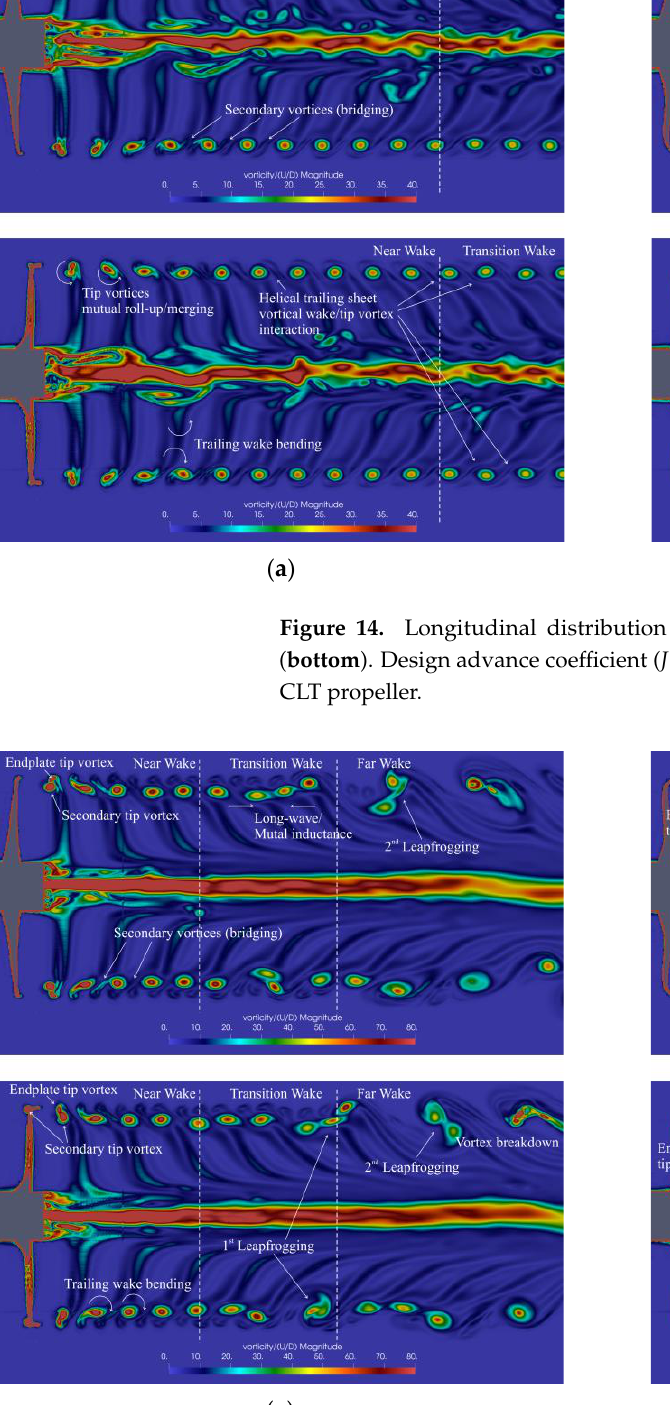
Figure 15. Longitudinal distribution of vorticity (magnitude) at time t ( top ) and t + 80 deg. ( bottom ). Loaded condition ( J = 0.6). ( a ) Conventional CLT propeller; ( b ) New generation CLT